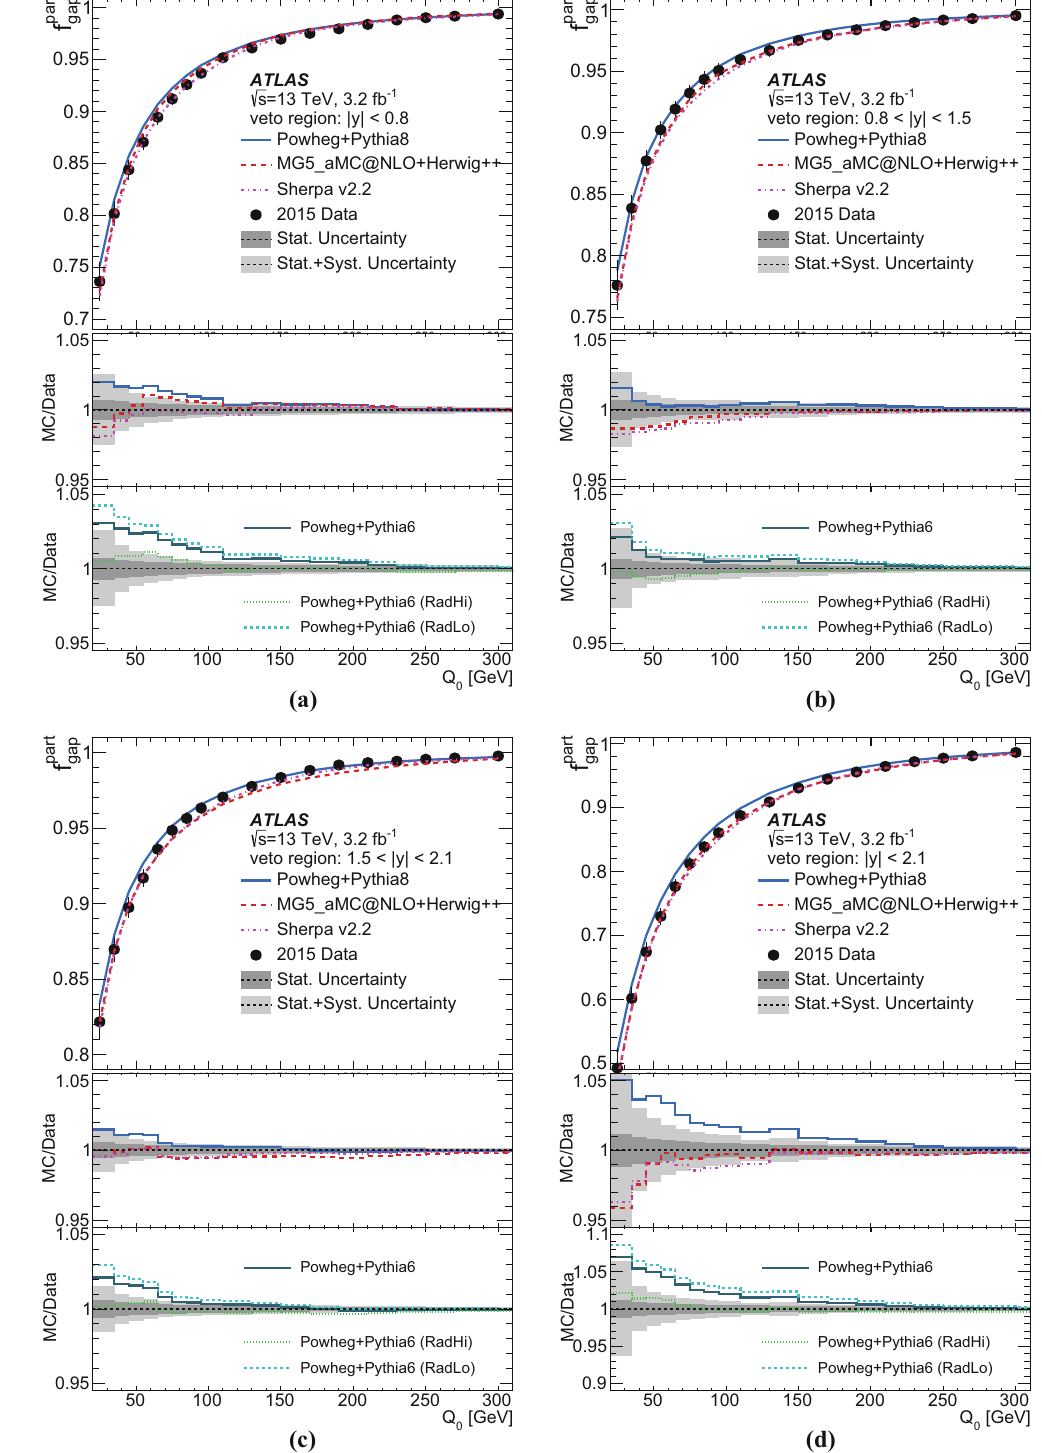
Fig. 9 The measured gap fraction f part gap ( Q 0 ) as a function of Q 0 in different rapidity veto regions, a | y | < 0 . 8, b 0 . 8 < | y | < 1 . 5, c 1 . 5 < | y | < 2 . 1 and d | y | < 2 . 1. The data are shown by the points with error bars indicating the total uncertainty, and compared to the pre- dictions from various t ¯ t simulation samples shown as smooth curves .